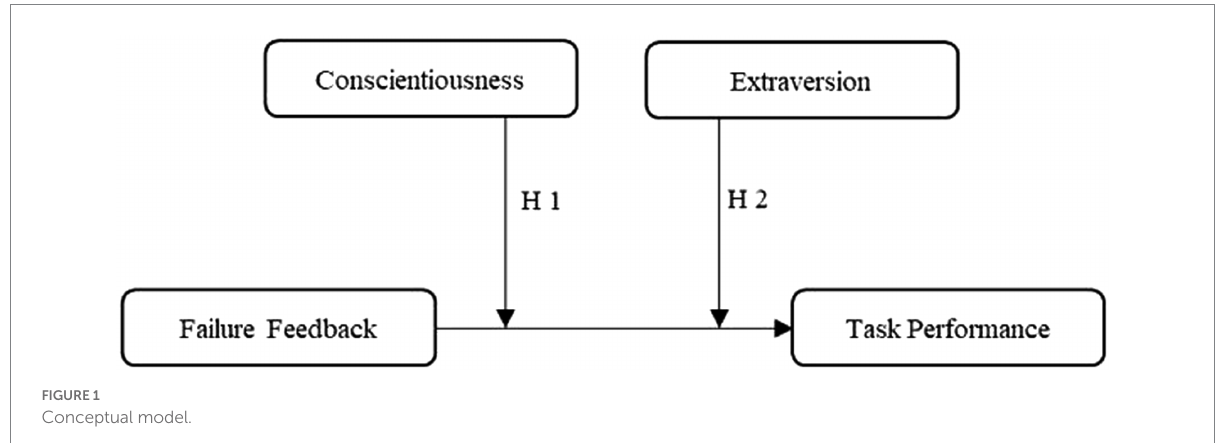
FIGURE 1 Conceptual